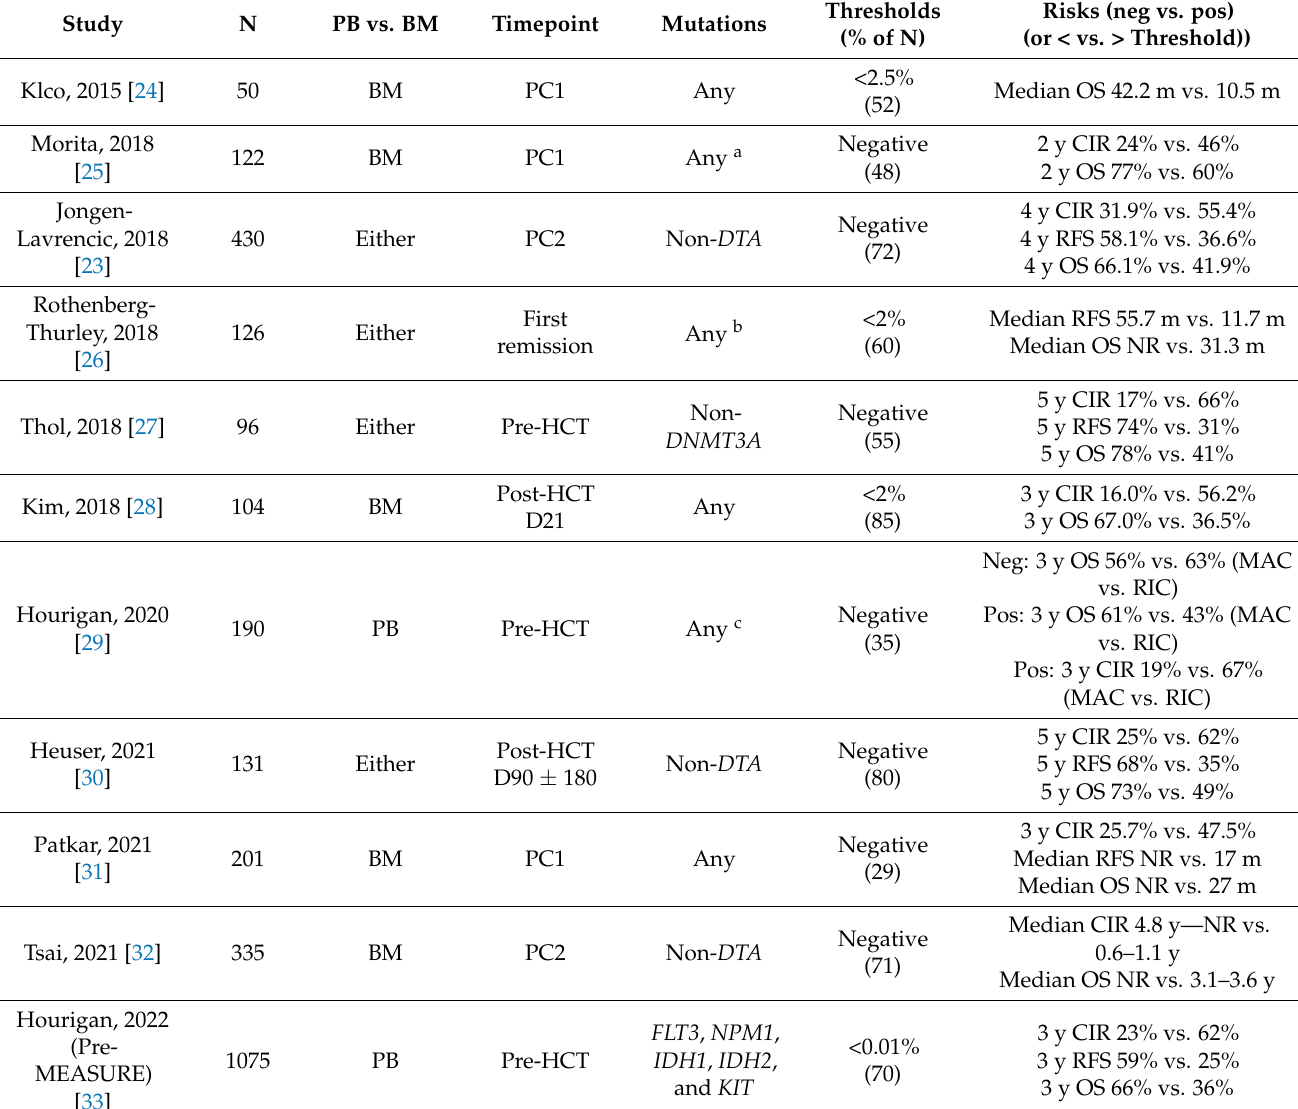
Table 2. Summary of studies evaluating MRD by targeted NGS panel in